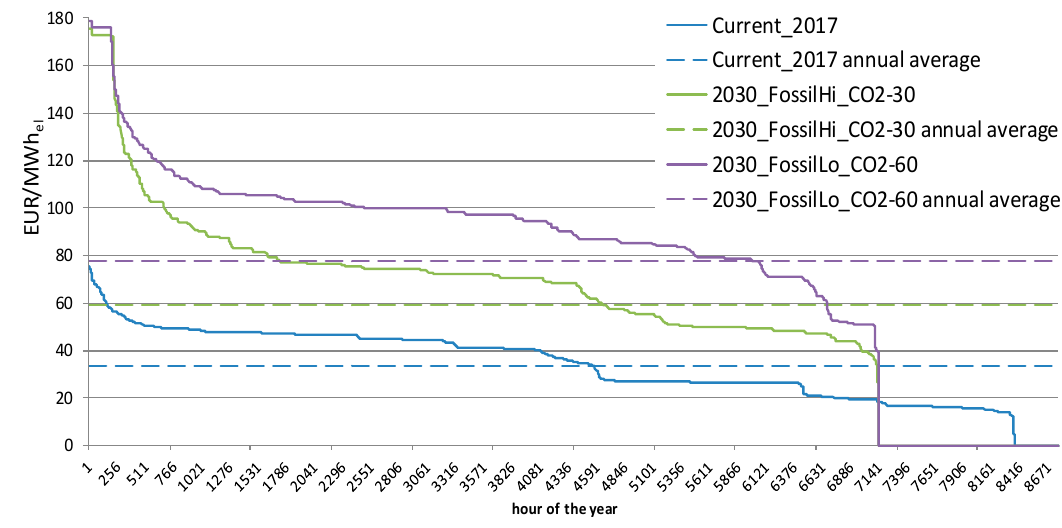
Figure 2. Hourly electricity prices sorted by size and annual average price for the three scenarios as an outcome of the electricity market